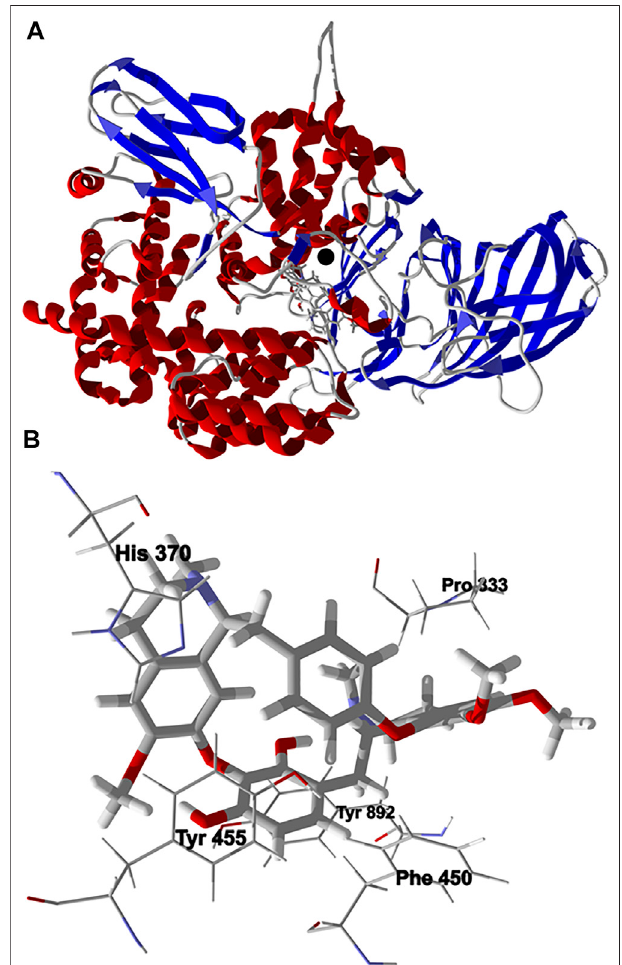
FIGURE 5 | Lowest-energy docked pose of chondrofolinol with human endoplasmic reticulum aminopeptidase 2 (Hs ERAP2, PDB 4JBS). (A) : Ribbon structure (the Z 2+ ion is shown as a black sphere and the docked ligand is shown as a stick fi gure). (B) : Binding site showing key intermolecular interactions of chondrofolinol with the